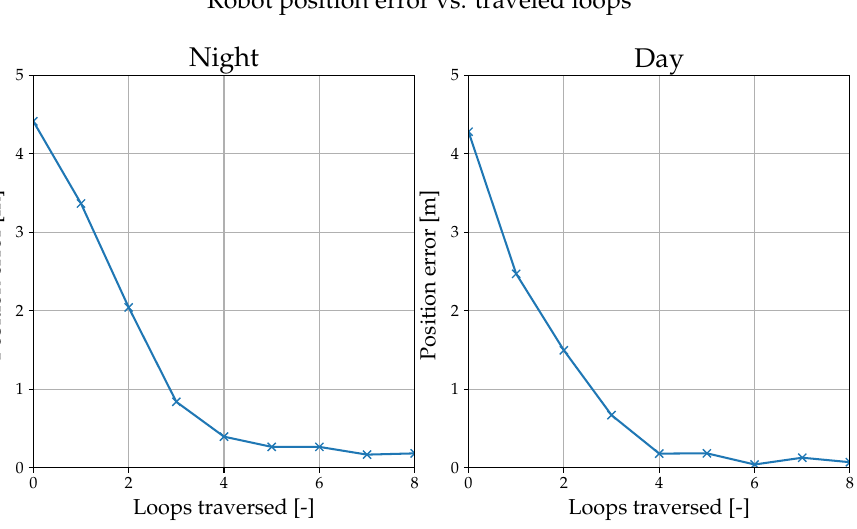
Figure 13. The lateral position error while traversing a closed path. Marked points indicate that the vehicle traveled the full loop and was starting a new